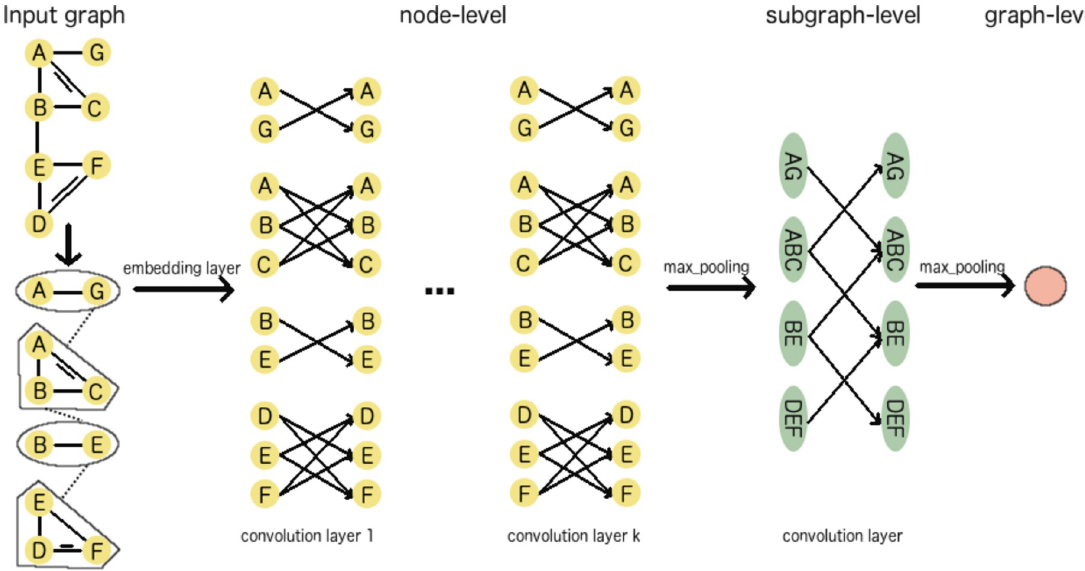
Fig 2. An illustration of the forward propagation of a HGCN which consists of T ( a ) = k convolution layers at node-level and T ( sg ) = 1 at